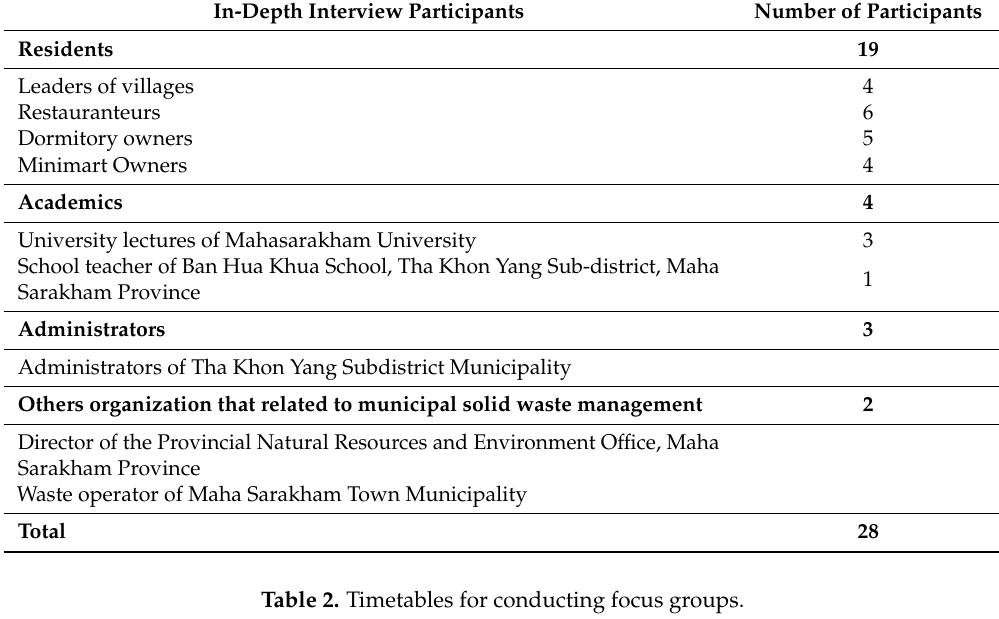
Table 2. Timetables for conducting focus